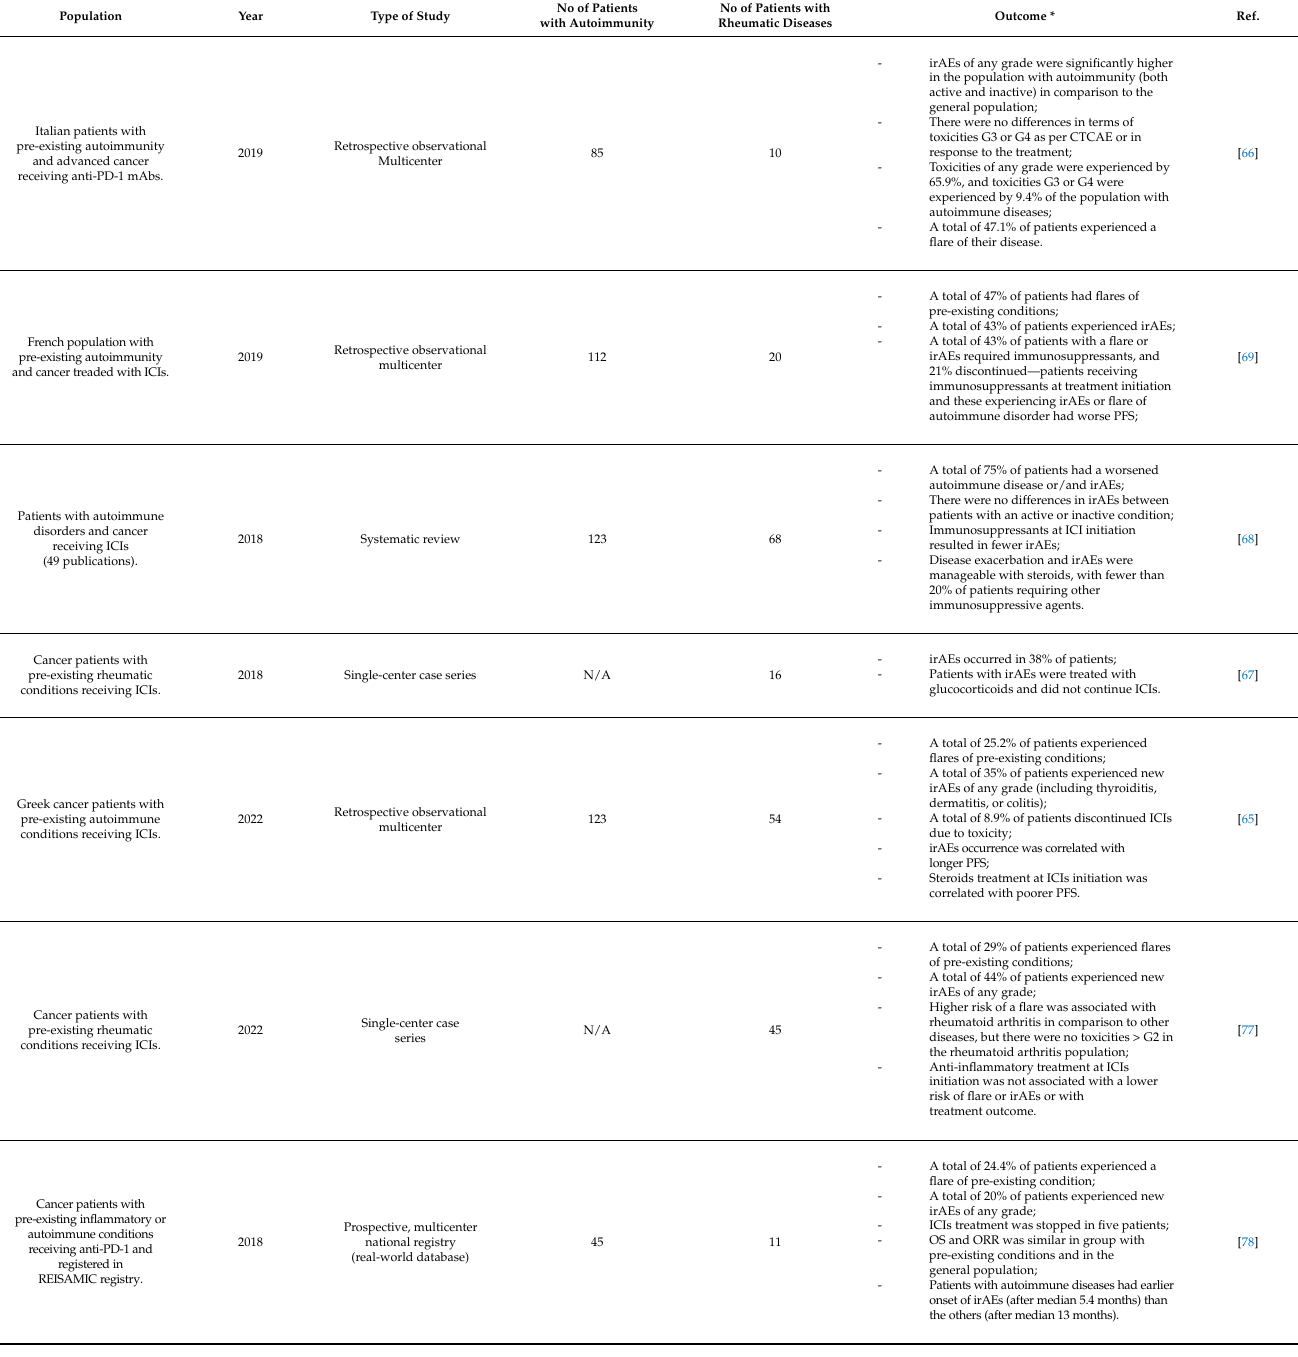
Table 3. Summary of studies regarding the population of cancer patients with pre-existing rheumatic conditions receiving immune checkpoint